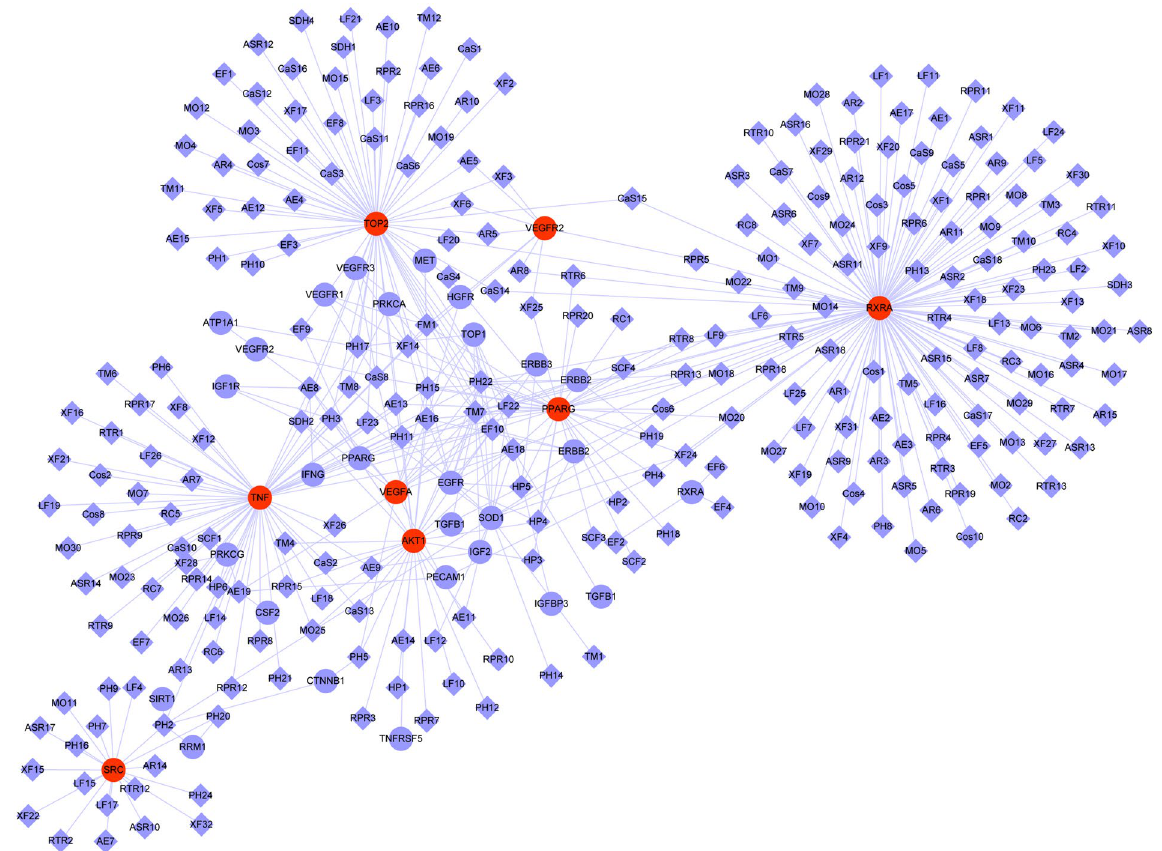
Figure 6. Network of all the candidate ingredients and candidate protein targets of the 18 herbs for CRC treatment. The diamond nodes represent ingredients, the circular nodes represent targets, and the nodes with red color are the major ingredients and targets involved in CRC